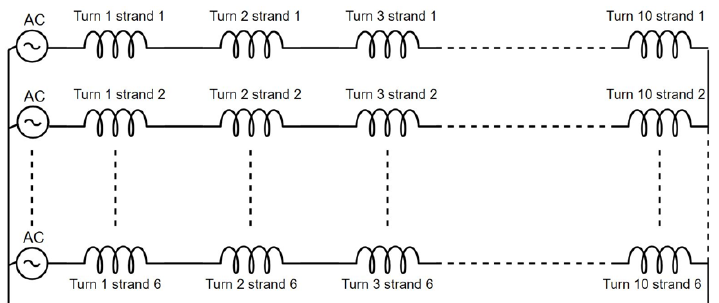
Figure 14. Circuital representation of the strands and bundle connections in the models with multiple supply sources, each connected to an individual strand.